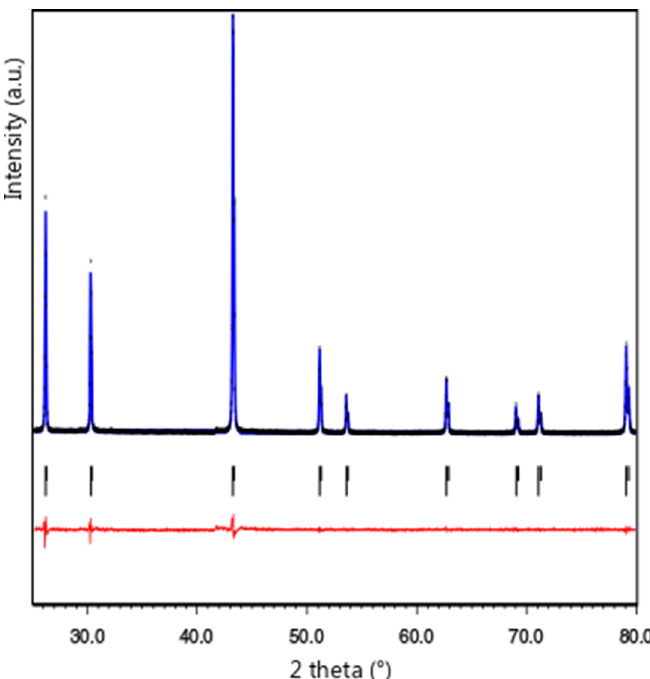
Figure 10. Experimental XRD pattern ( λ = 1.5418 Å) of the powder from a sample prepared by MA at 400 rpm and annealed for 10 days at 750 °C. Full Rietveld refinement (lattice and atom positions) to R p = 4.5, wRp = 6.2, GoF = 2.0, and R Bragg = 0.4 confirms NiTiSn as the unique component (black marks: Bragg positions, black dots: Measured intensities, blue and red lines: Calculated and difference intensity plots).